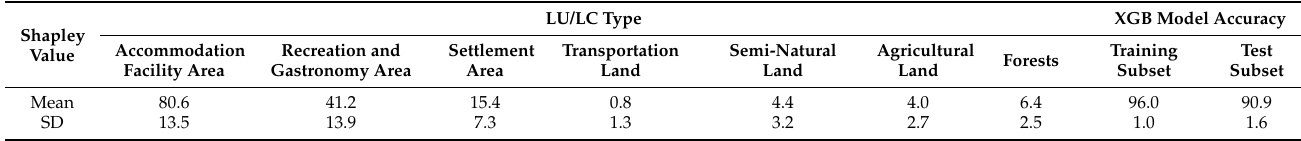
Table 3. Overall LU/LC type importance for tourist function of lakes expressed by normalised absolute Shapley values (in %): mean +/ − Standard Deviation (SD) and Extreme Gradient Boosting (XGB) accuracy. Mean was calculated for 5 SHAP model executions.